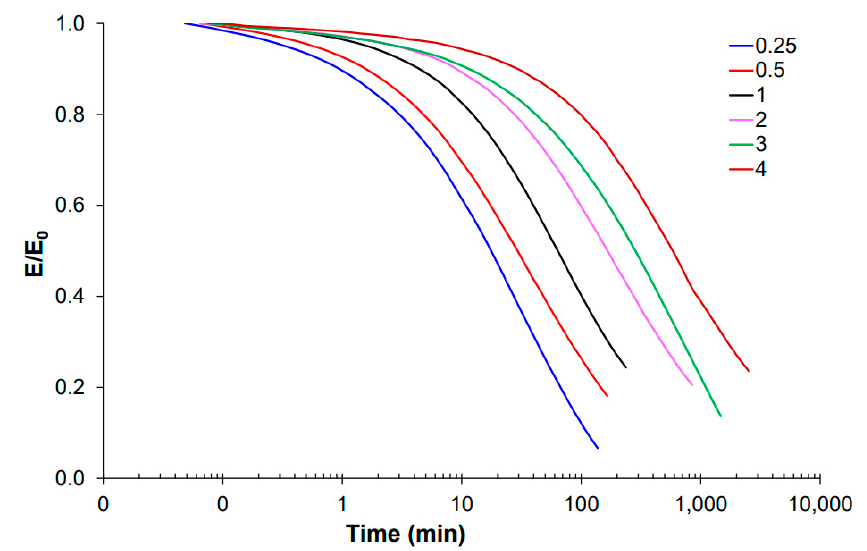
Figure 3. Stress relaxation at 180 °C of formulations with varied acrylate:epoxy ratios using the characteristic relaxation time.